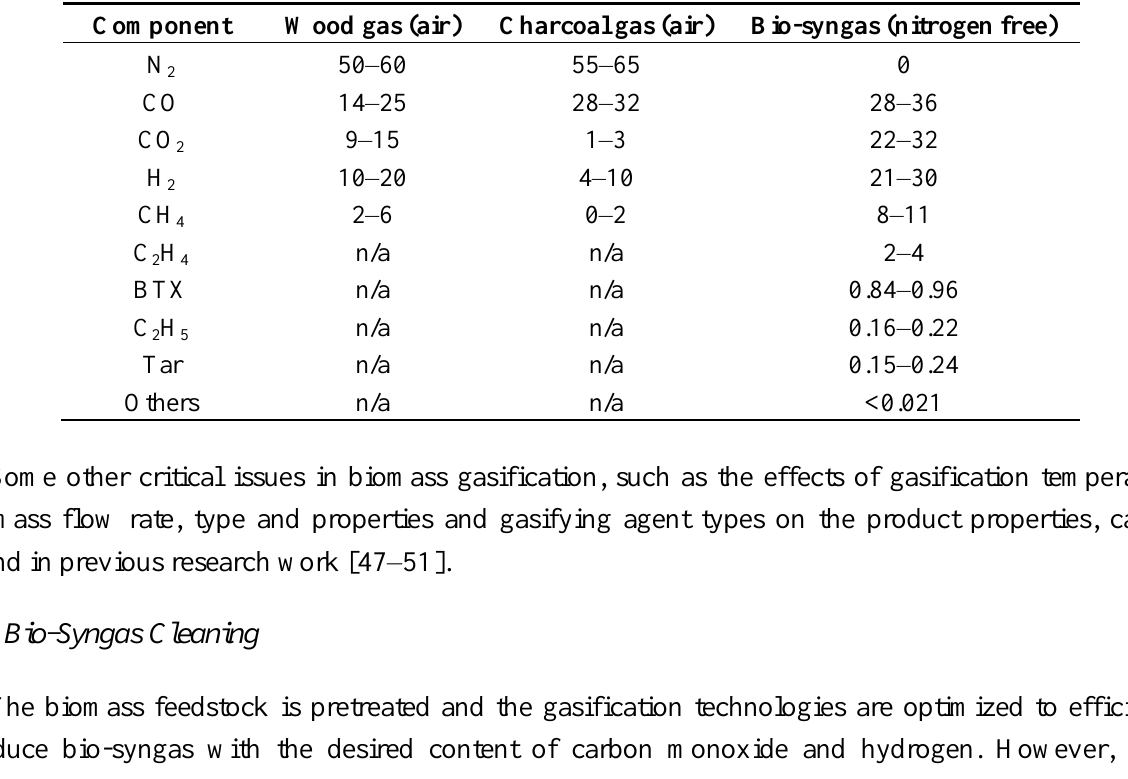
Table 3. Composition of gas produced from gasification of wood and charcoal in ambient air [43] and also the composition of typical nitrogen free bio-syngas